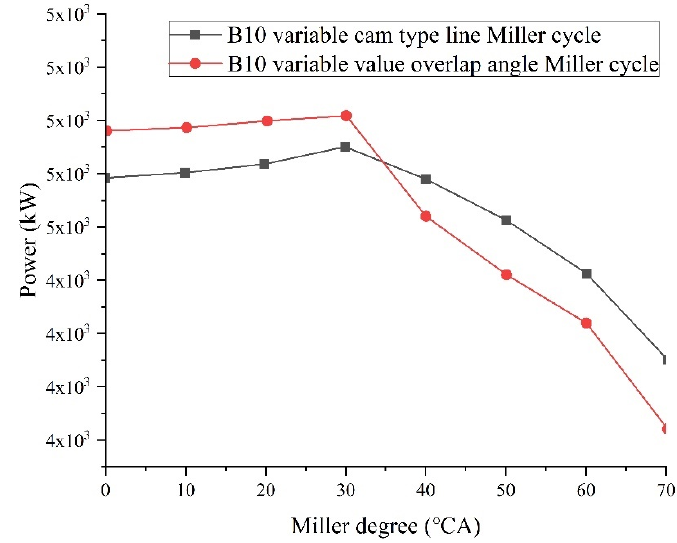
Figure 17. Comparison of two Miller cycles’ power.